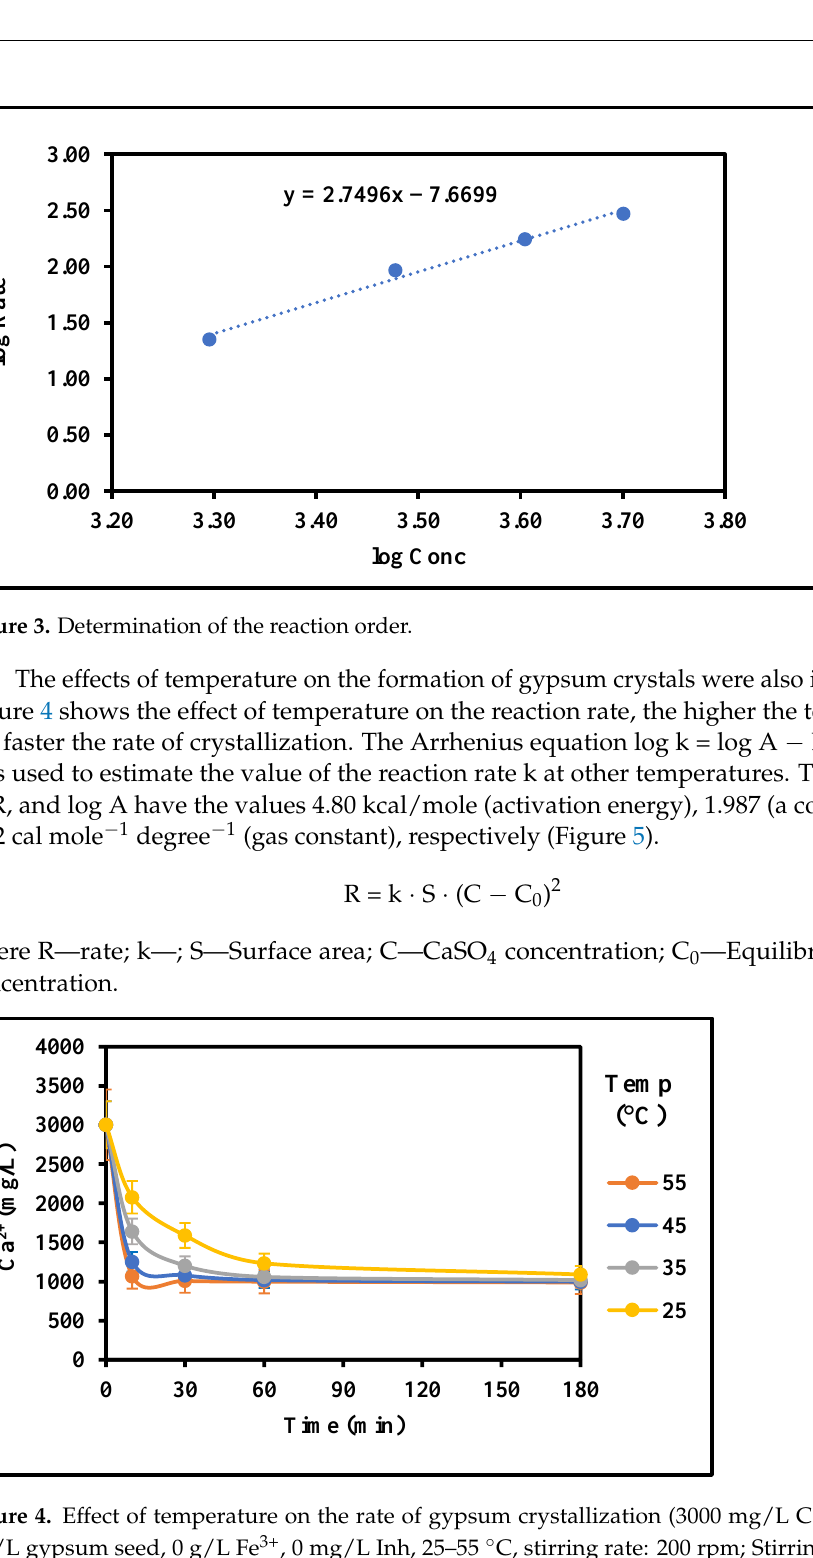
Figure 4. Effect of temperature on the rate of gypsum crystallization (3000 mg/L CaSO 4 (as Ca), 5 g/L gypsum seed, 0 g/L Fe 3+ , 0 mg/L Inh, 25 – 55 °C, stirring rate: 200 rpm; Stirring time (min): 180/180).